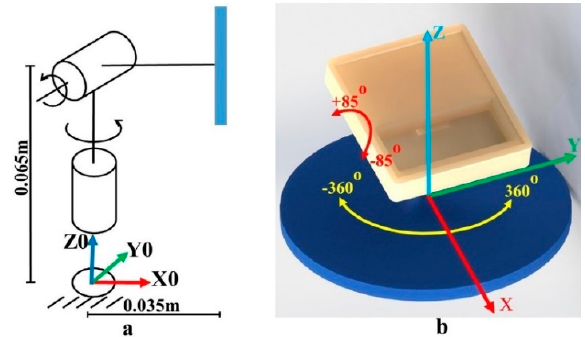
Figure 17. ( a ) Kinematic model, ( b ) a supportive platform to capture the object’s ground truth with respect to the robot (for both the front and back sides).